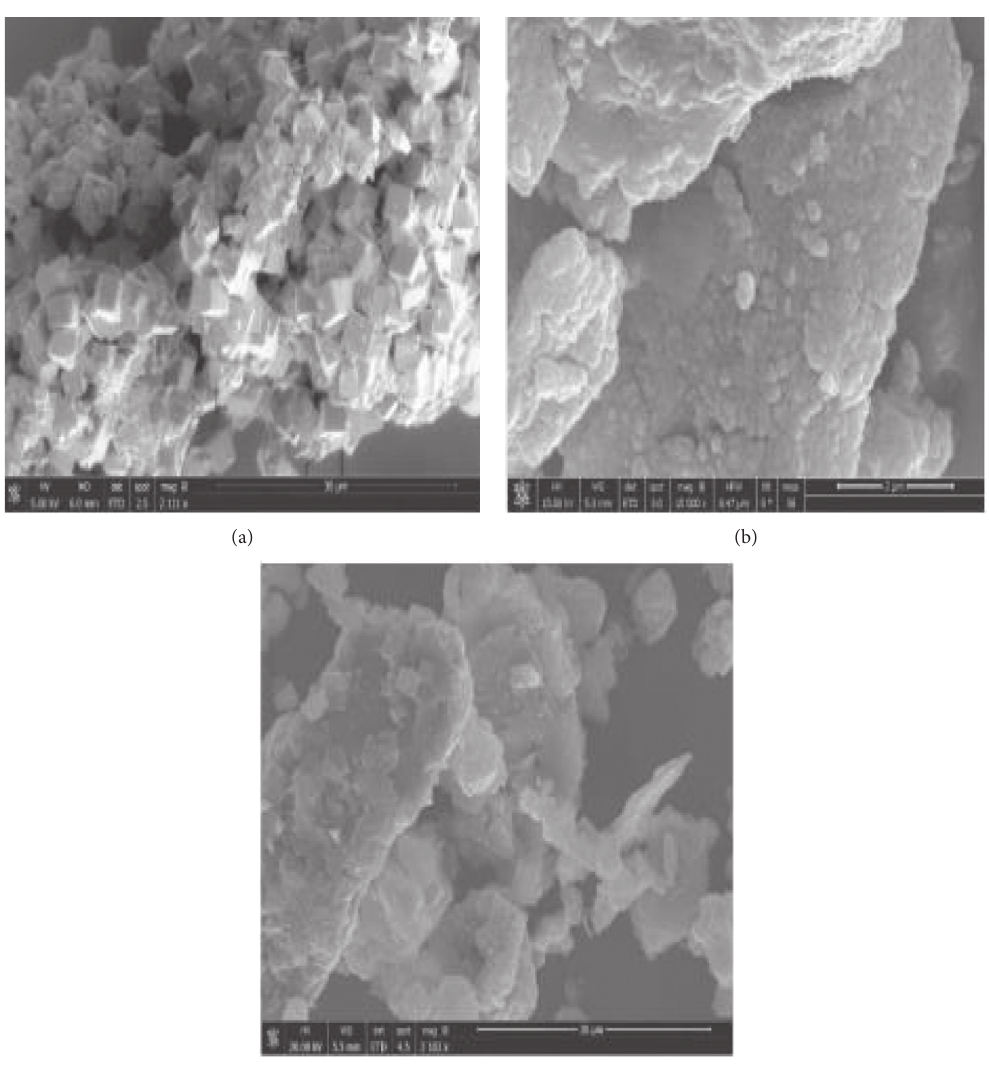
Figure 6: SEM of (a) pure zeolite, (b) Fe